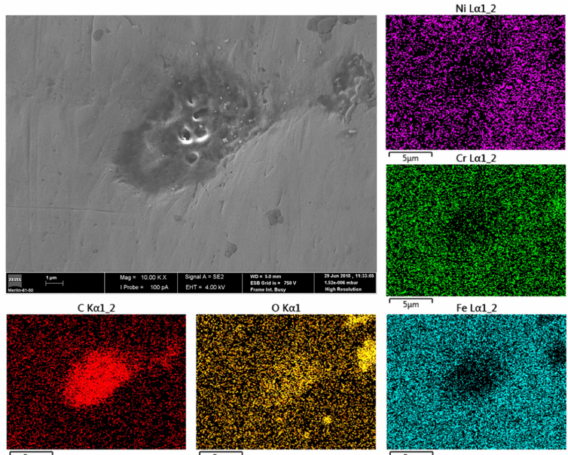
Figure 7. SS tube after two years of intraoral use: surface SEM micrograph and the corresponding EDS elemental distribution